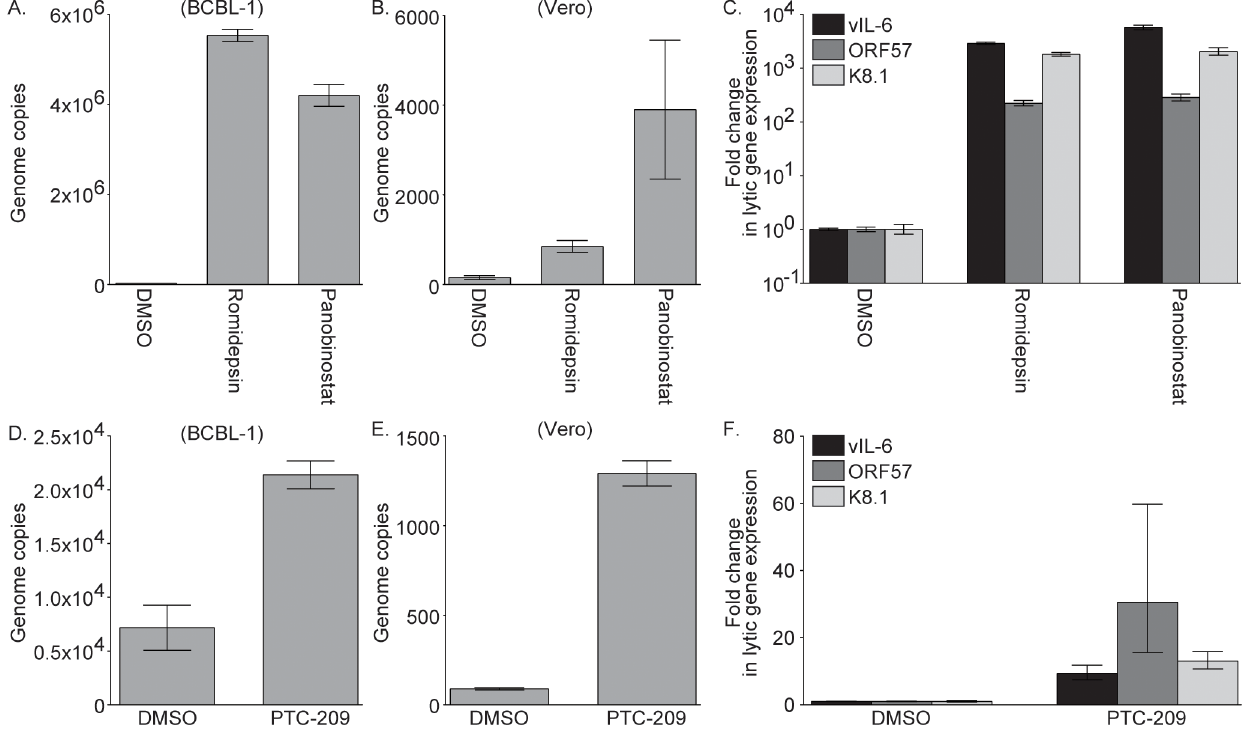
Fig 4. Romidepsin, Panobinostat, and PTC-209 induce KSHV genome replication and release of infectious virions. (A) qPCR analysis for cell- associated KSHV genome copies was performed on BCBL-1 cells treated with DMSO or 1 μM Romidepsin or Panobinostat for five days. Naïve Vero cells were infected with supernatants collected from BCBL-1 cells treated as in (A), and KSHV genome copies in the infected cells were determined by qPCR (B), and KSHV lytic transcript levels were assayed by RT-qPCR (C). Lytic transcript levels were normalized to GAPDH, and the fold difference between DMSO and compound treated cells was calculated. (D) qPCR analysis for cell-associated KSHV genome copies was performed on BCBL-1 cells treated with DMSO or 10 μM PTC-209 for seven days. Naïve Vero cells were infected with supernatants collected from BCBL-1 cells treated as in (D), and KSHV genome copies in the infected cells were determined by qPCR (E), and KSHV lytic transcript levels were assayed by RT-qPCR (F). Lytic transcript levels were normalized to GAPDH, and the fold difference between DMSO and PTC-209 treated cells was